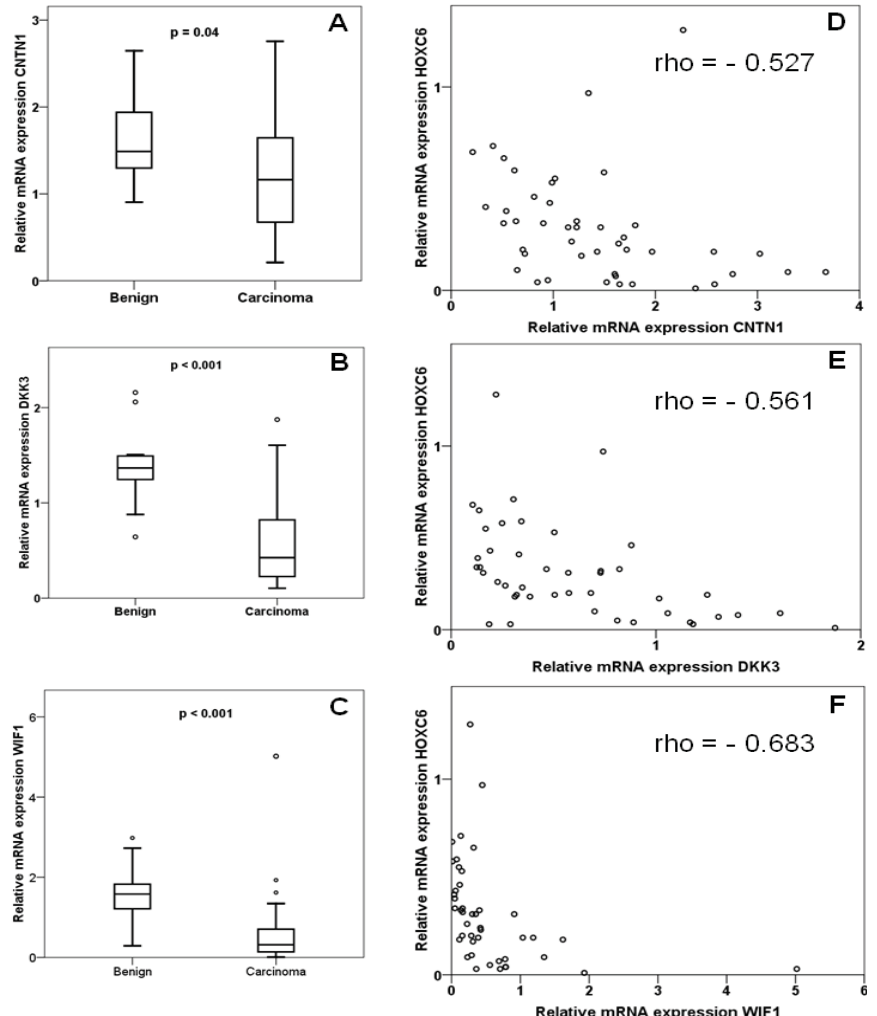
Figure 2. Expression of HOXC6 target genes in prostate cancer. ( A ) Expression of CNTN1 mRNA as measured by quantitative RT-PCR in 45 prostate carcinoma and 13 benign prostate tissues; ( B ) Expression of DKK3 mRNA in the same set of tissues; ( C ) Expression of WIF1 mRNA in the same set of tissues; ( D – F ) Plots of CNTN1 , DKK3 and WIF1 expression